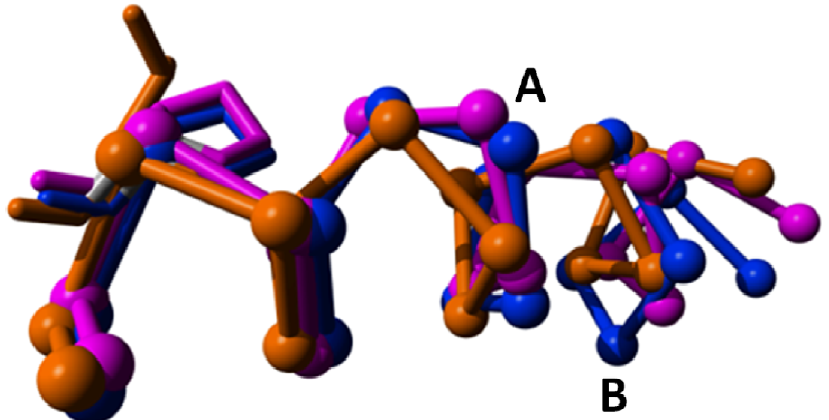
Figure 10. The area around the bulge in helix-V. The S1P lipid receptor (orange, PDBid = 3v2y [45]) does not have α -bulges in helix V and is given as a reference. Rhodopsin (magenta, PDBid = 1f88 [2]) and the adenosine-2A receptor (blue, PDBid = 3eml [46]) have an α -bulge (A) between positions 516 and 517; and the adenosine-2A receptor has an extra bulge (B) between positions 511 and 512. Side chains of residues at position 520 are shown. Rhodopsin and the adenosine-2A receptor have a proline at position 520. The S1P lipid receptor, which does not have bulges in helix V, does not have a proline at position 520. Time will tell if this correlation is accidental or